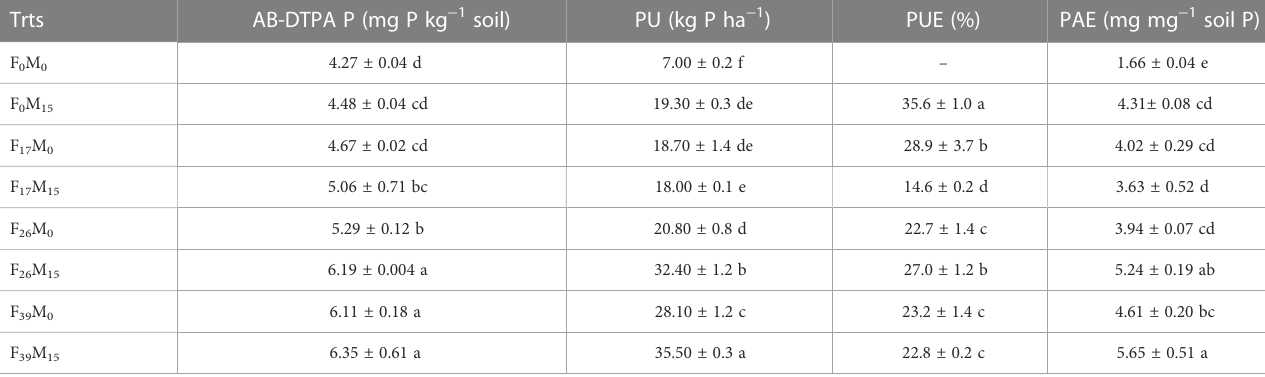
TABLE 5 Field study: effect of fertilizer phosphorus (P) and farmyard manure (FYM) application on postharvest plant-available P (AB-DTPA extractable P), P uptake (PU), P use ef fi ciency (PUE), and P acquisition ef fi ciency (PAE). Trts